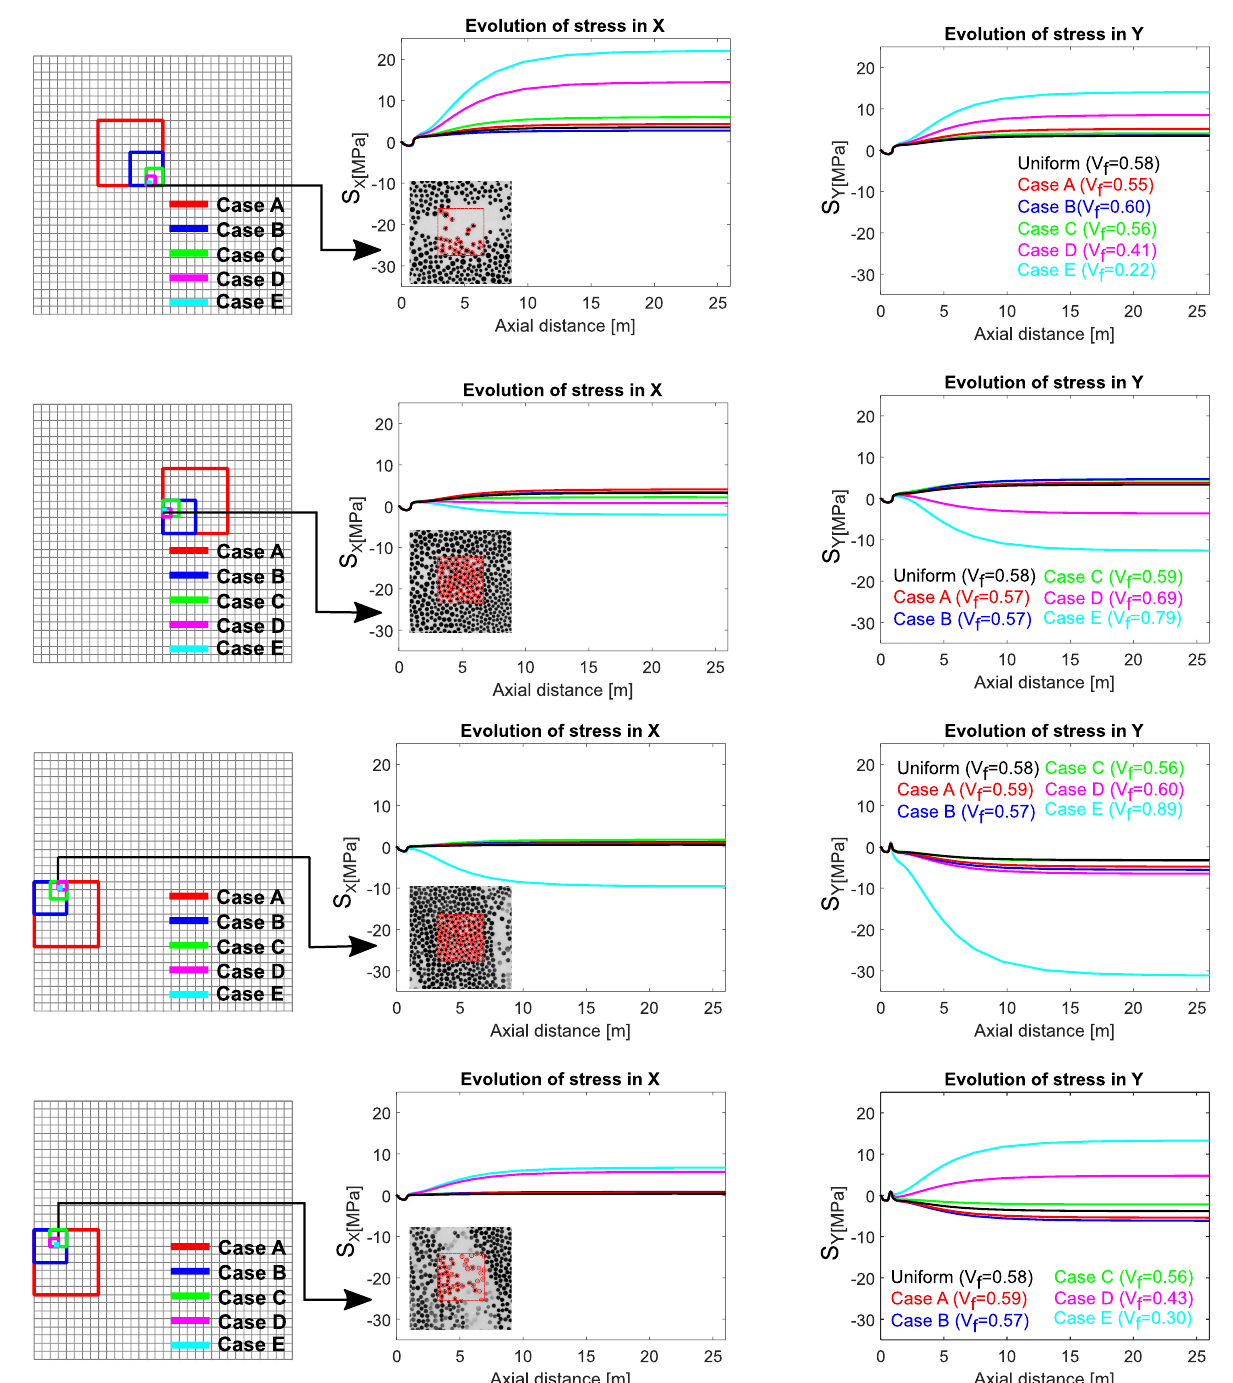
Figure 9. Local residual stress evolution within the selected RVEs. Schematic representations of the corresponding locations in the cross-section are on the left column (the grid is representative for ‘Case D’). Stress evolution curves in the X-direction are on the middle column. Stress evolution curves in the Y-direction are on the right